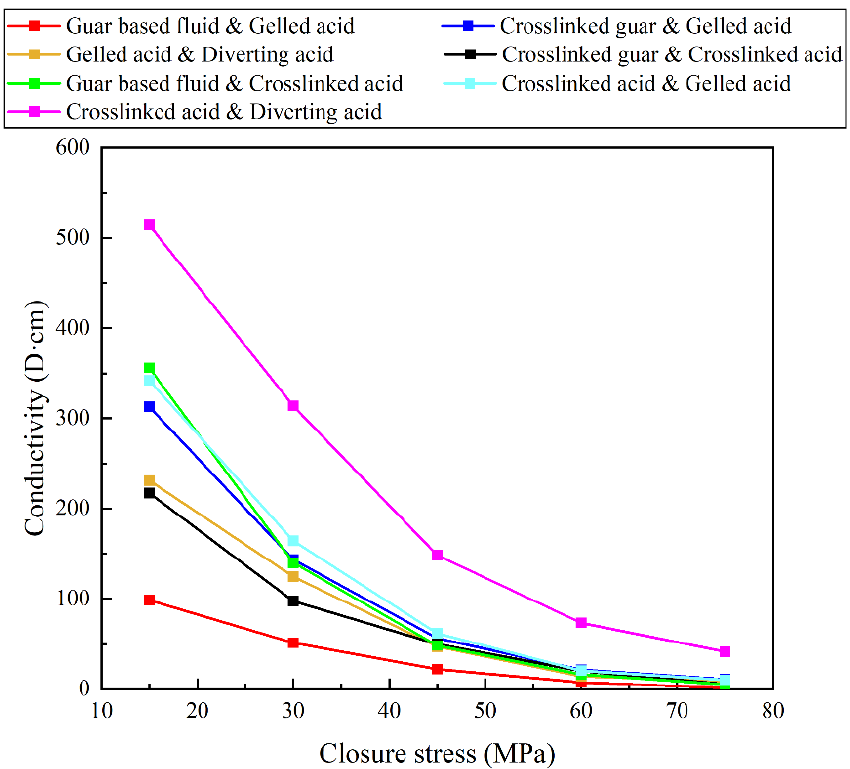
Figure 6. Conductivity under multistage alternate injection of different fluid combinations.